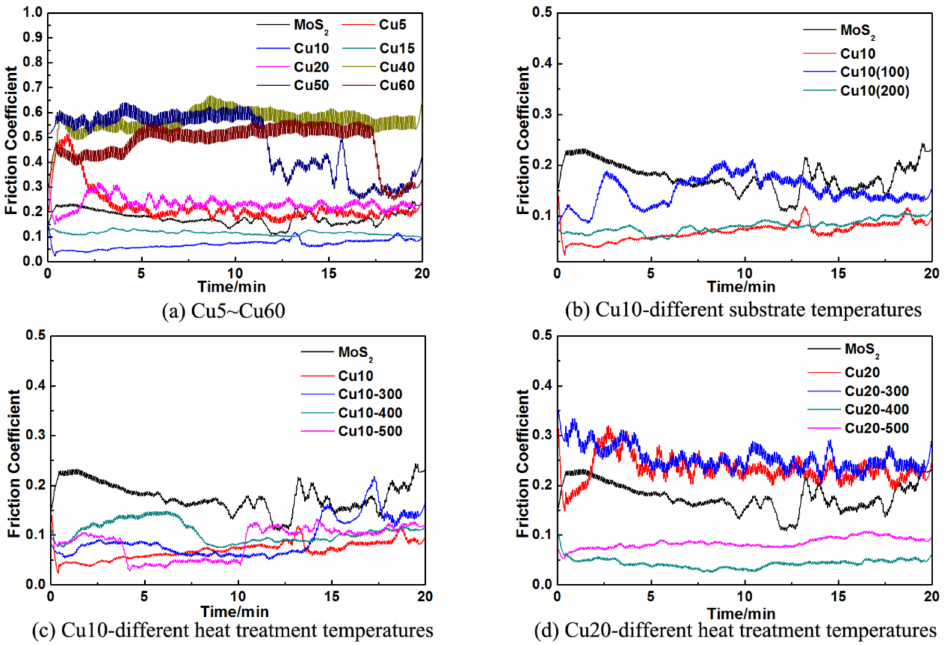
Figure 5. Friction coefficients of Cu/MoS 2 composite coatings at various heat treatment